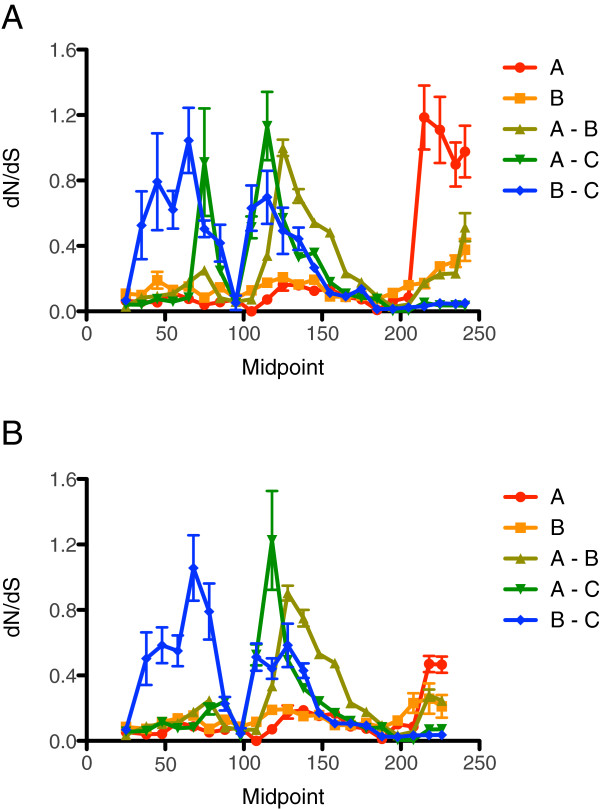
Mean pairwise dN/dS values along a sliding window of the mmr-b repeats. (A) full repeats; (B) terminal repeats. Error bars indicate standard error.